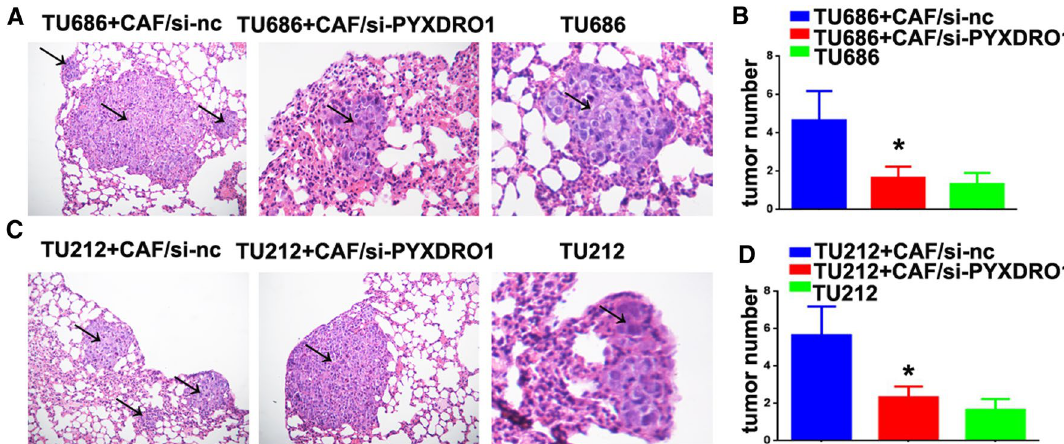
Fig. 4 PYROXD1 induces LSCC metastasis in nude mice. A TU686 + CAF/si-PYROXD1, TU686 + CAF/si-nc and TU212 + CAF/si-nc and TU686 cells were injected into nude mice. H&E staining of pulmonary nodules (black arrows, ×100). B Pulmonary tissue and nodules were analyzed by H&E staining, and pulmonary nodules were observed after 42 days (N = 5/group, *P < 0.05). C TU212 + CAF/si-PYROXD1, TU212 + CAF/si-nc and TU212 cells were injected into nude mice. H&E staining of pulmonary nodules (black arrows, ×100). D Pulmonary tissues and nodules were analyzed by H&E staining, the nodules were observed after 42 days (N = 5/group, *P <